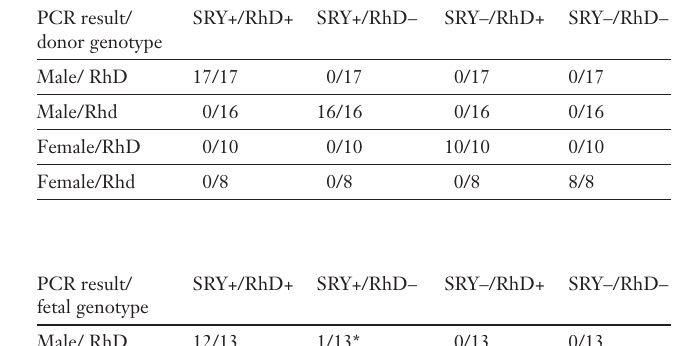
Accuracy of real-time multiplex PCR in deter- mining sex and Rhesus D status on cell free DNA isolated from the plasma of pregnant